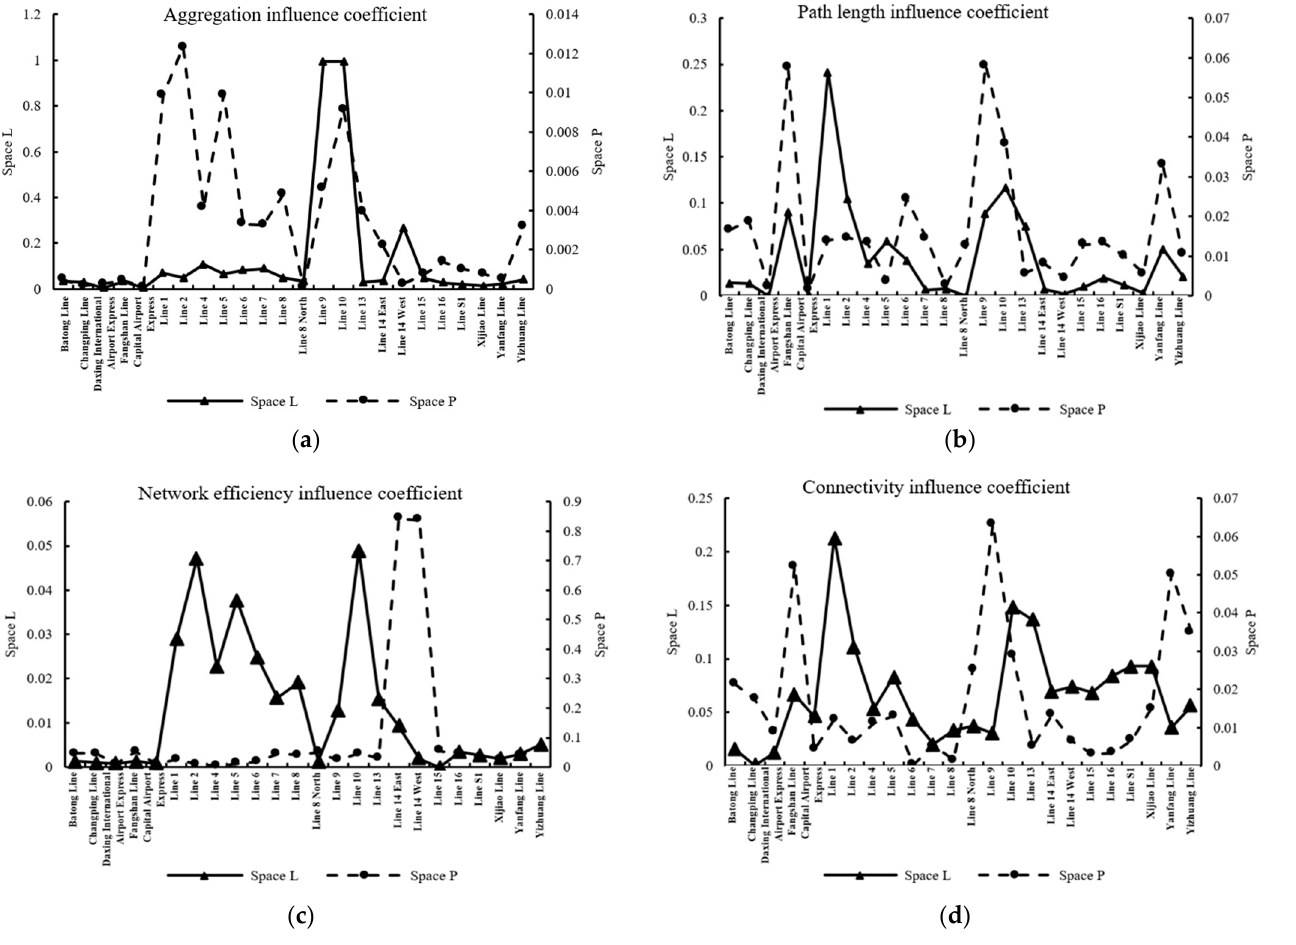
Figure 7. Comparison of global impact indexes. ( a ) Aggregation influence coefficient. ( b ) Path length influence coefficient. ( c ) Network efficiency influence coefficient. ( d ) Connectivity influence coefficient.